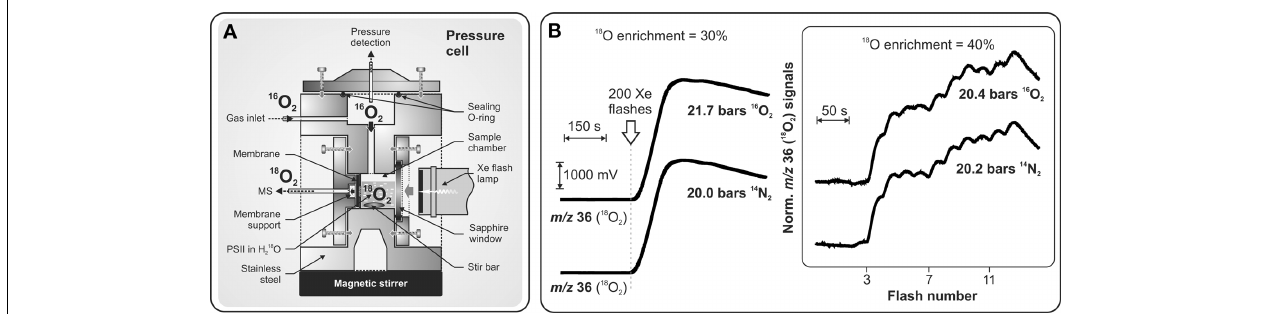
Other conditions: 30% H 18 2 O enrichment; [Chl] = 50 μ M; 250 μ M DCBQ, pH 6.7, 20 ◦ C. Right: Flash-induced 18 O 2 evolution patterns of PSII membrane fragments from spinach induced by a series of saturating laser flashes (separated by dark times of 25s) at 20.4 bars O 2 , or 20.2 bars N 2 . Other conditions: as above, but with 40% H 18 2 O. Adapted from Shevela et al. (2011a).